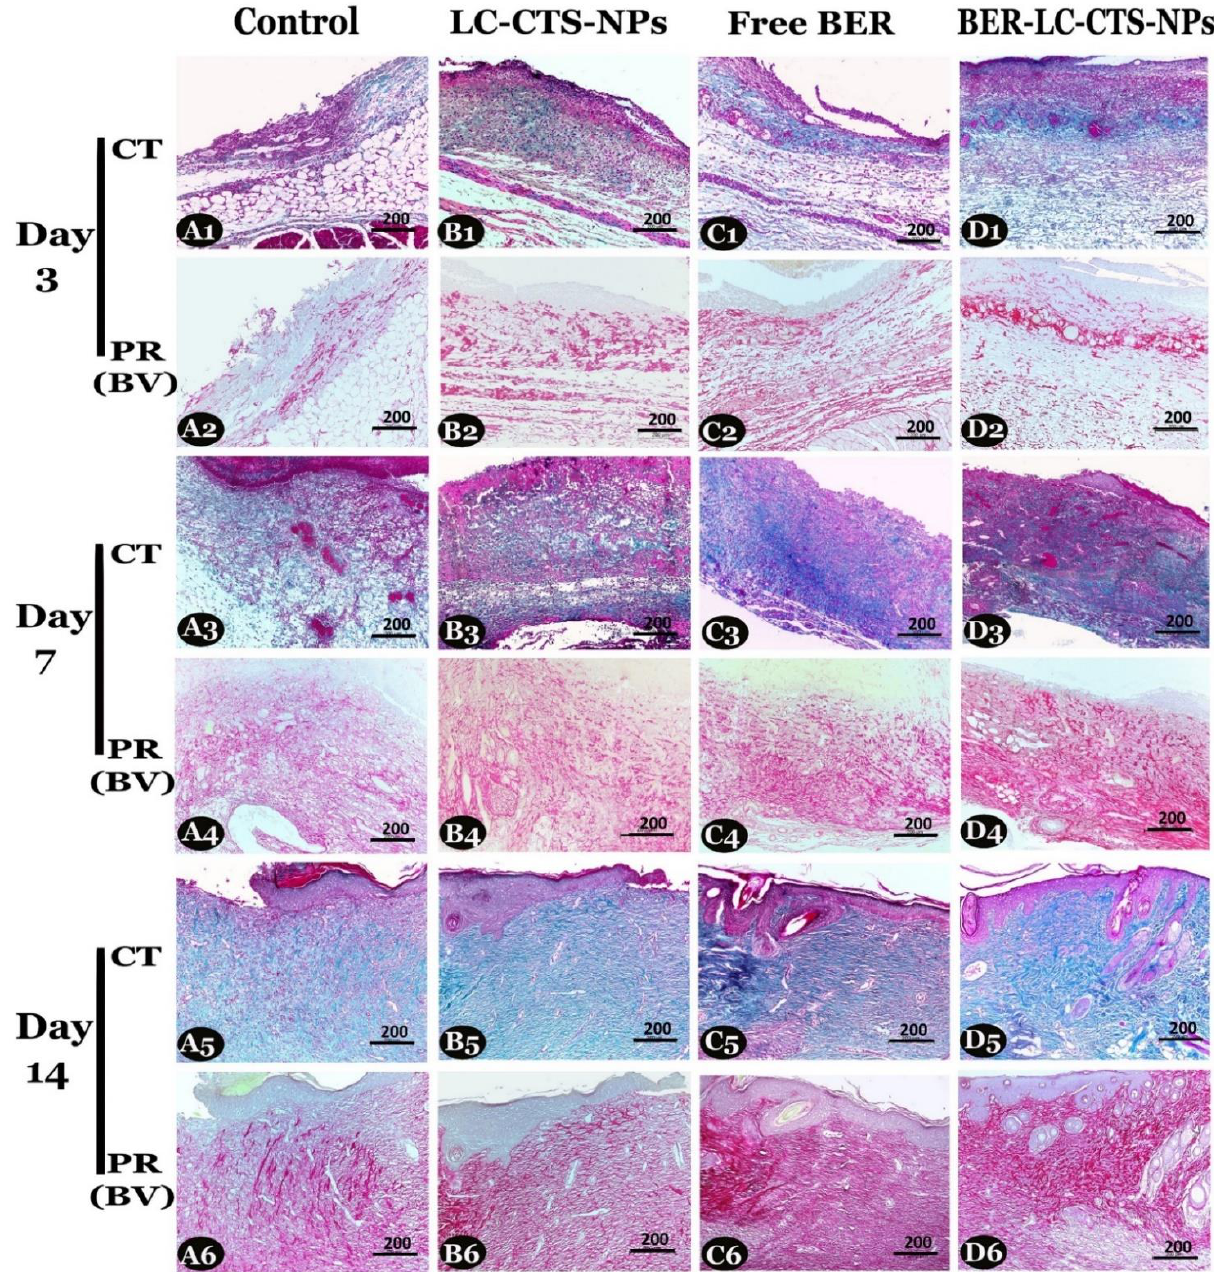
Figure 9. Representative skin sections × 100 used for collagen quantification, on days 3, 7, and 14 post wound creation in the diabetic rats of the Control ( A1 – A6 ), LC-CTS-NPs ( B1 – B6 ), Free BER ( C1 – C6 ), and BER-LC-CTS-NPs ( D1 – D6 ) groups. Collagen fibers are stained green with Crossman’s trichrome (CT) (1st, 3rd, and 5th rows) and red with Picrosirius red stain (bright-field view (PR (BV)) (2nd, 4th, and 6th rows). Note: in all days, collagen fibers were the highest in the Free BER and BER-LC-CTS-NPs groups. On day 14, fibers were organized as short bundles in wound borders of all groups but appeared also in the wound center in the Free BER and BER-LC-CTS-NPs groups only.